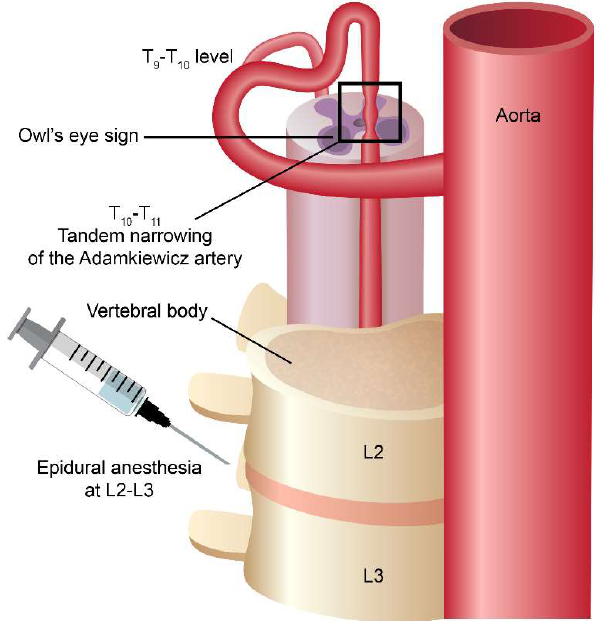
Figure 2. The cartoon figure depicts the spatial relationship between the epidural anesthesia site and the spinal cord infarction site. The infarction location is a little far from the epidural anesthesia location, thus the epidural anesthesia itself as the possible cause of the spinal cord infarction is less